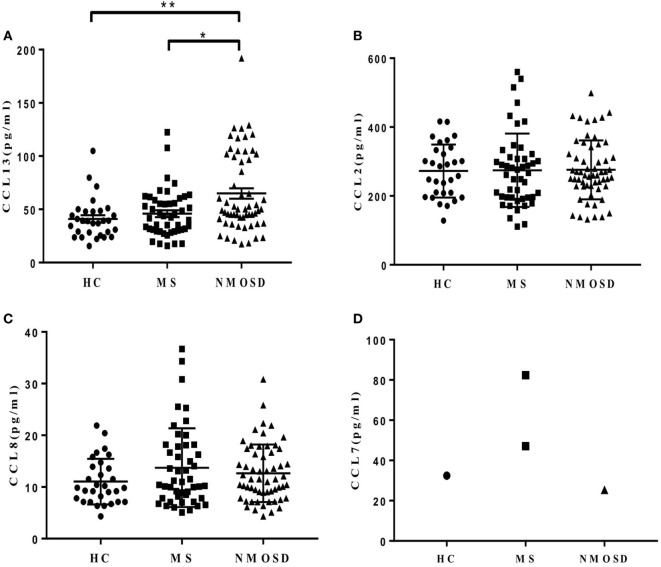
Plasma levels of monocyte chemoattractant proteins (CCL13, CCL2, CCL8, and CCL7). (A) Plasma CCL13 levels in healthy control (HC), multiple sclerosis (MS) patients, and neuromyelitis optica spectrum disorder (NMOSD) patients (mean ± SE). (B,C) No significant differences of CCL2 and CCL8 levels were found among plasma in HC, MS patients, and NMOSD patients (mean ± SE) (P = 0.89 and 0.39, respectively). (D) Plasma CCL7 levels in almost all subjects were below measurable levels. Kruskal–Wallis H-test and Dunn’s post hoc analysis were used. *P < 0.05, **P < 0.01.